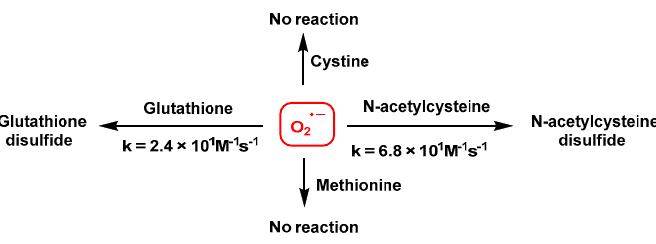
Figure 49. Rate constants for the reaction of N-acetylcysteine and glutathione with O 2• − .